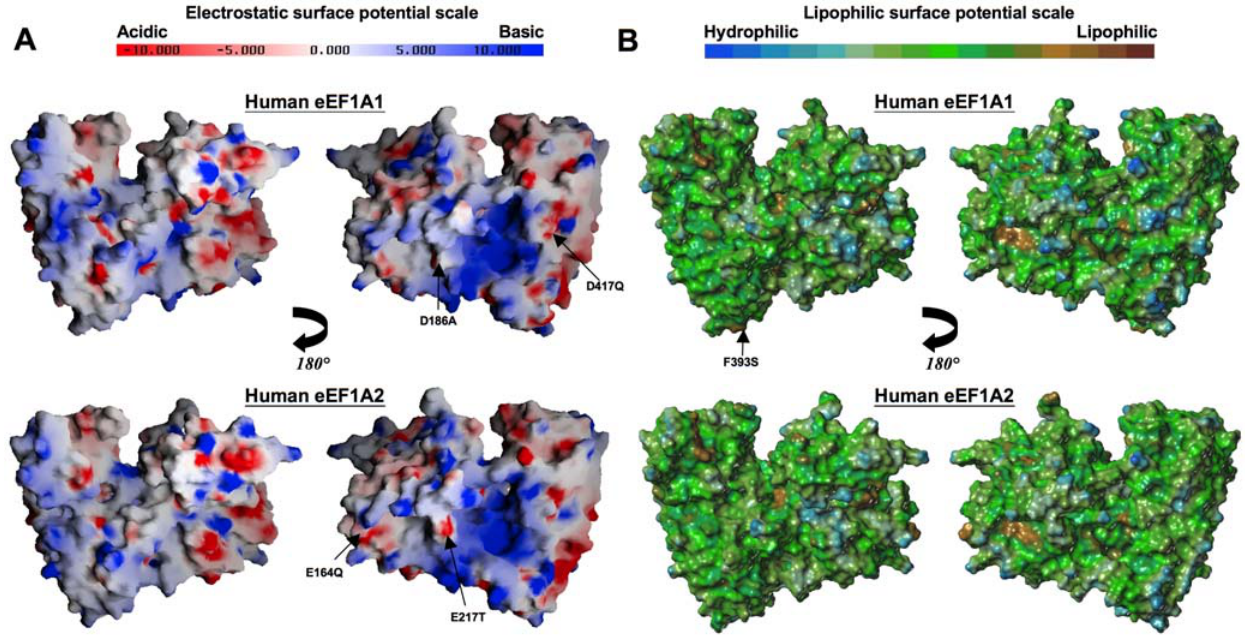
Figure 5. Surface properties of the models eEF1A1 and eEF1A2. (A) Two equivalent views, rotated by 180 u about the y -axis, of a GRASP- generated [56] surface electrostatic representation of eEF1A1 (upper panel) and eEF1A2 (lower panel). Negative charge is colored red and positive charge colored blue, ranging from -10 kT to + 10 kT (k=Boltzmann’s constant; T=temperature in Kelvin). Charged residues not present in either protein (non-conservative charged substitutions only) are labeled – the variant equivalent residue is shown on the right-hand side of the label. (B) Two equivalent views, rotated by 180 u about the y -axis, of a MOLCAD-generated [57] lipophilic surface rendition of the models. Regions of high lipophilicity or hydrophobicity are colored brown and regions of high hydrophilicity are colored blue.